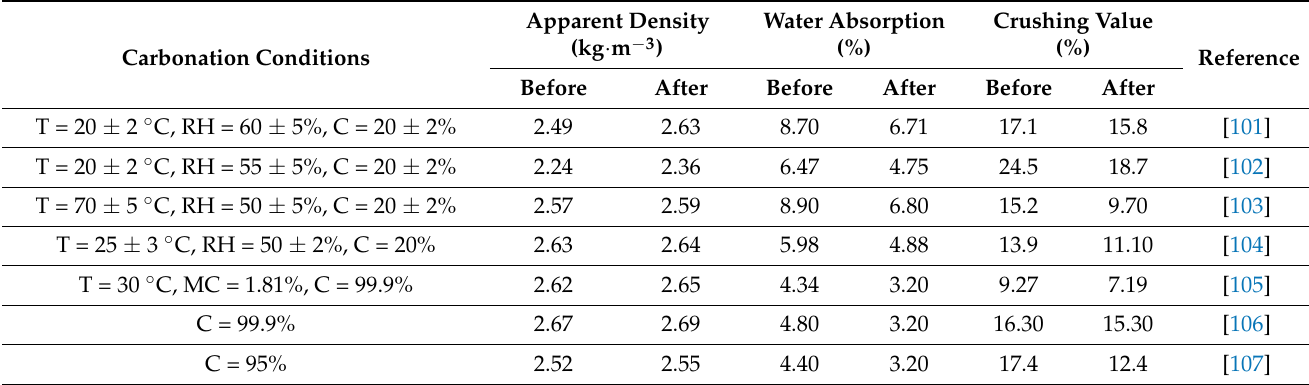
Table 3. Effect of carbonation on basic properties of recycled aggregates.